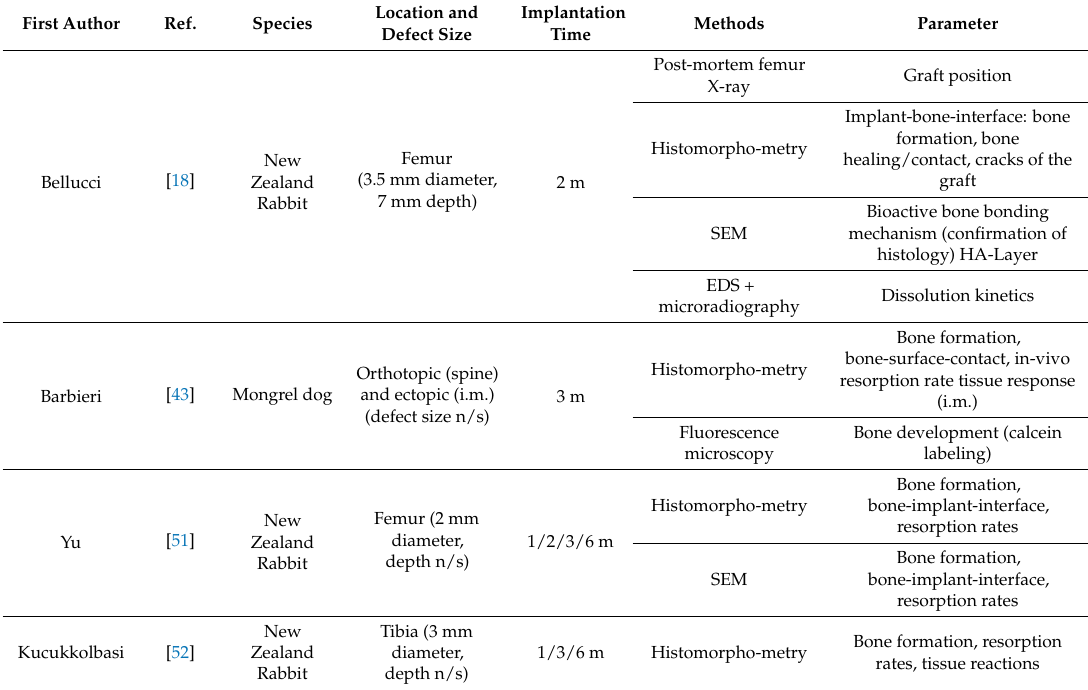
Table 3. In-vivo evaluation